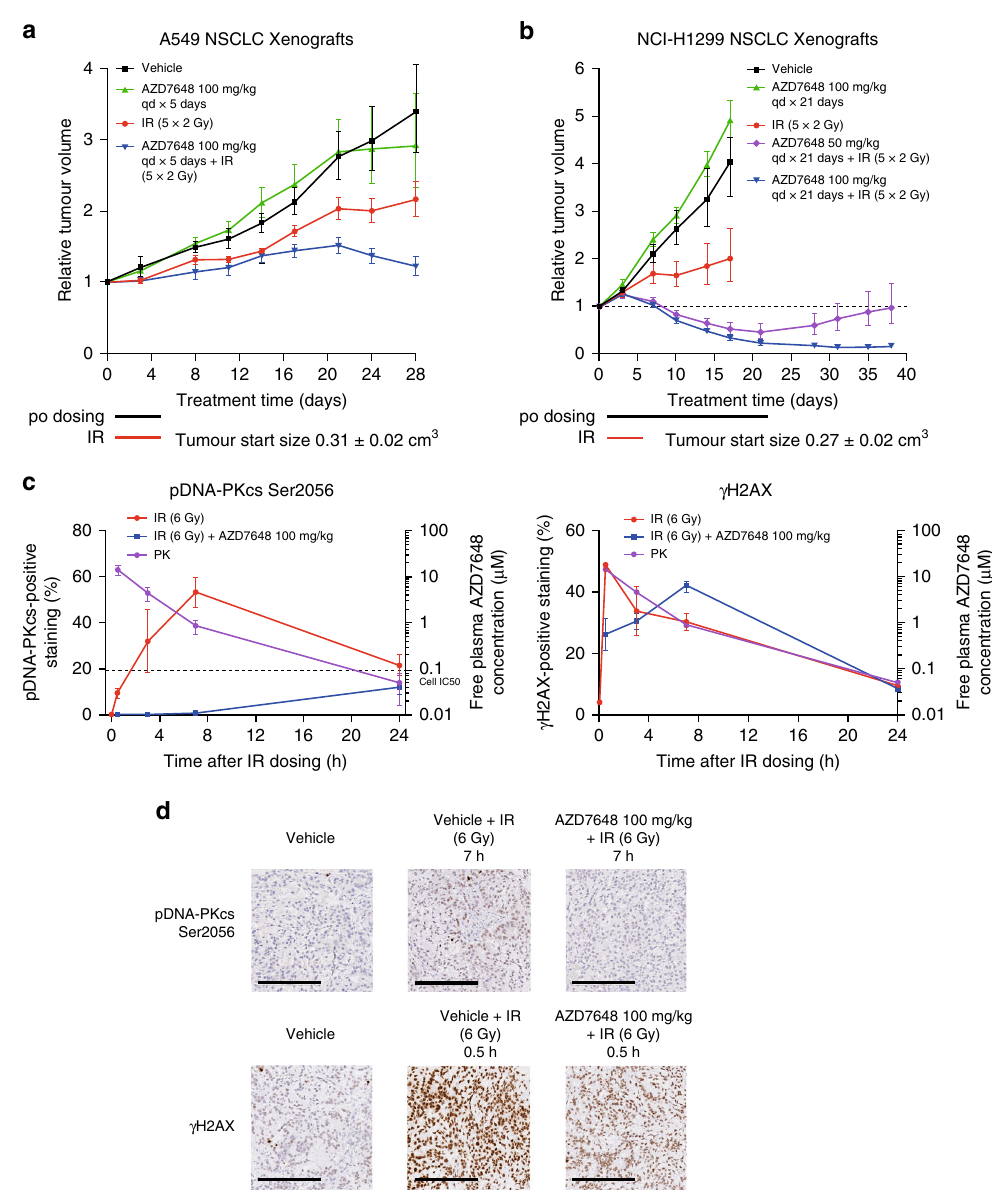
Fig. 2 AZD7648 is a potent radiosensitizer of tumours in vivo. a A549. AZD7648 induces tumour growth inhibition in combination with IR in A549 xenografts (nude mice, vehicle and combination n = 11, IR n = 12, AZD7648 n = 9, geometric mean ± SEM). b NCI-H1299. AZD7648 induces tumour regression in combination with IR in NCI-H1299 xenografts (nude mice, vehicle n = 13, IR and AZD7648 100 mg kg − 1 combination n = 11, AZD7648 single agent and 50 mg kg − 1 combination n = 12, geometric mean ± SEM). For a and b , corresponding mouse bodyweights and statistical analysis can be found in Supplementary Fig. 2A, B and Supplementary Table 3A. To assess tumour growth inhibition, one-tailed, two-sample, t -test with unequal variances was used and for tumour regression, one-sample t -test analysis. c , d Pharmacodynamic modulation of DNA-PK biomarkers and pharmacokinetics (PK) of AZD7648 after dosing of AZD7648 and IR in A549 xenografts. pDNA-PKcs Ser2056 and γ H2AX were measured by immunohistochemistry (image scale bars, 200 μ m; nude mice, 0 h n = 8, all treatments n = 5, mean ± SEM). Several comparisons between the IR and IR + AZD7648 treatments were found to be statistically signi fi cant using a one-way ANOVA. For pDNA-PKcs Ser2056: 0.5 h ( p < 0.0001), 3 h ( p = 0.0005) and 7 h ( p < 0.0001). For γ H2AX: 0.5 h ( p = 0.05) and 7 h ( p =